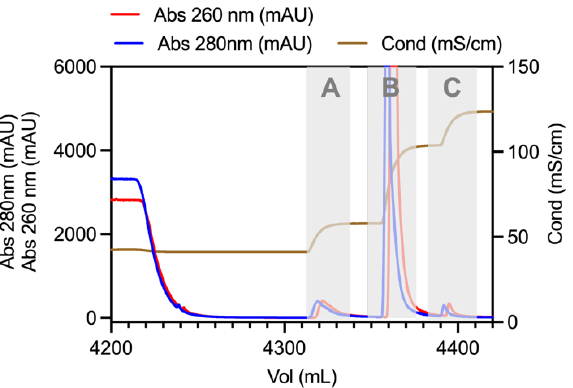
Figure A2. ( A ) Linear representation of fluorescence response vs rAAV2 total particles (TP/ml) concentration (average of analyst 1 run 1 assay). ( B ) Linear representation of fluorescence response vs MG1 concentration (VG/mL).